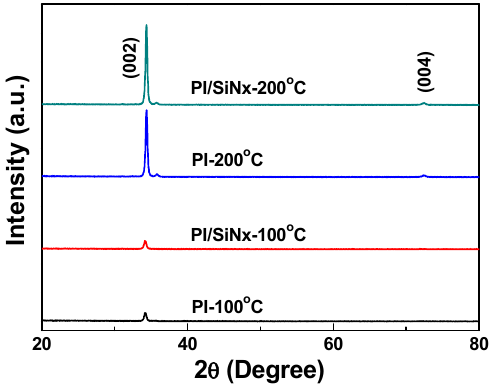
Figure 5. X-ray diffraction (XRD) diffraction patterns of the GZO thin films deposited on different substrates as a function of deposition